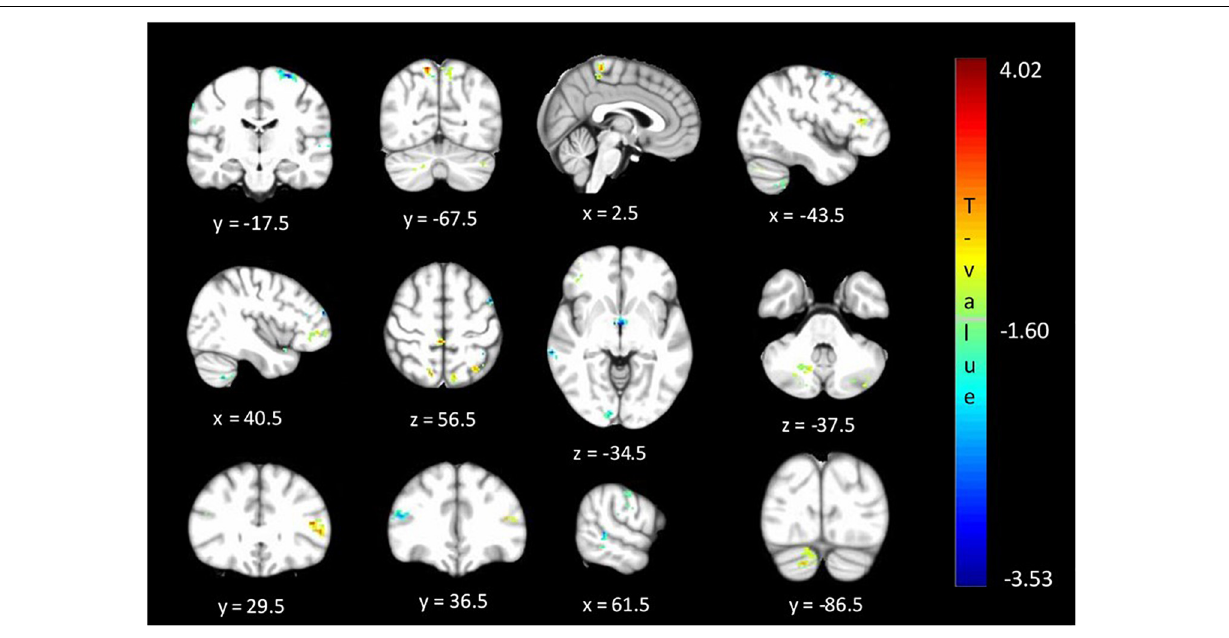
FIGURE 4 | Significant differences (corrected p < 0.05) in ALFF values between relatives with normal vs. abnormal TDT values. The blue/green colors represent regions where